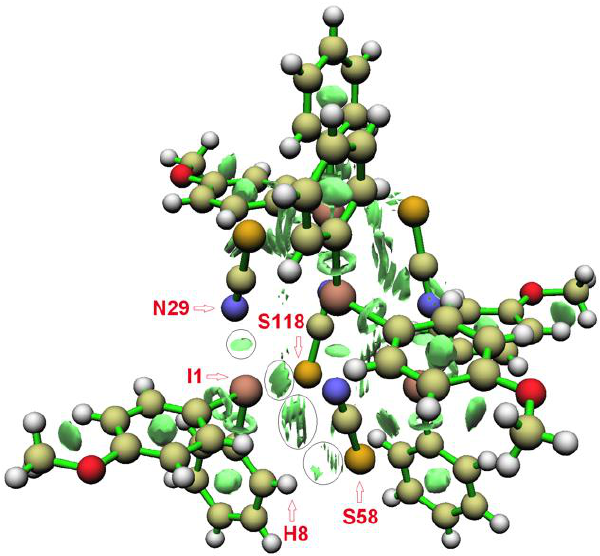
Figure 10. Visualization of intermolecular contacts I ··· S and I ··· N in {PhI(4-C 6 H 4 OMe)} 4 · {SCN} 4 using noncovalent interaction (NCI) analysis based on promolecular electron density (high quality grid, ~1728000 points in total). Numeration of atoms in the model structure corresponds to their ordering in Table S1, Supporting Information.